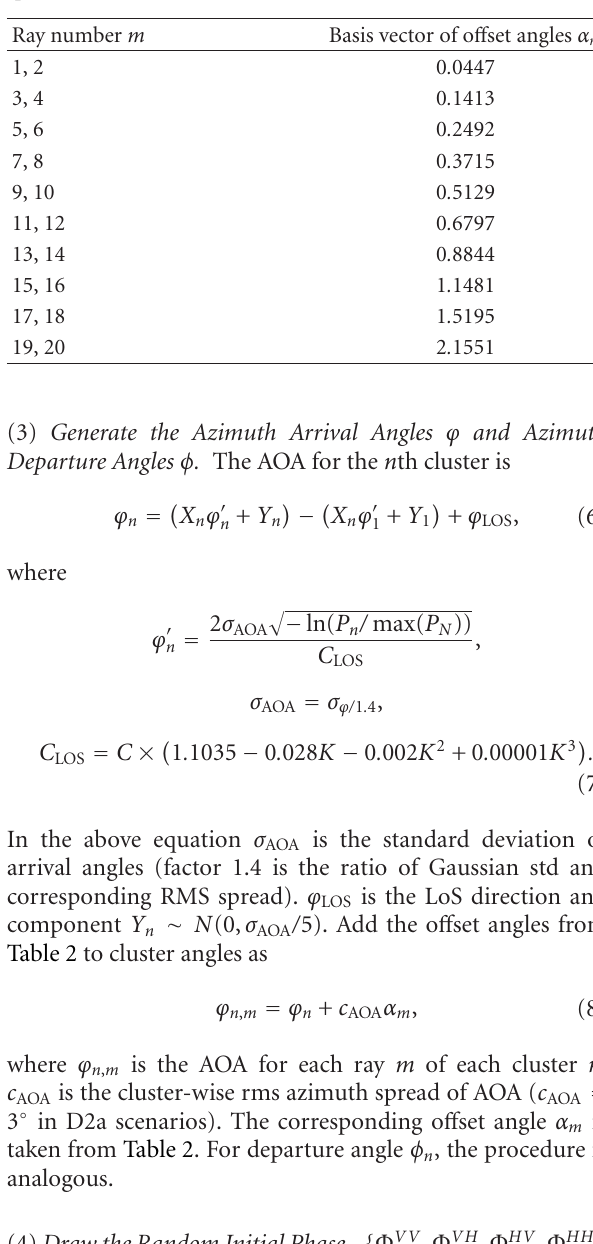
Table 2: Ray o ff set angles within a cluster, given for 1 ◦ rms angle